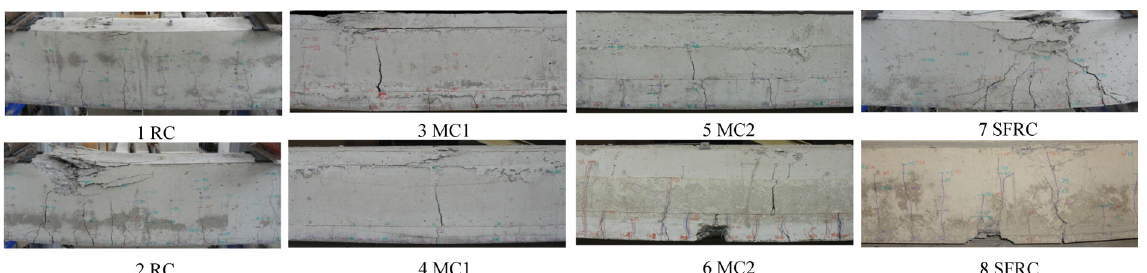
Fig. 4. Cracking layout on the beams